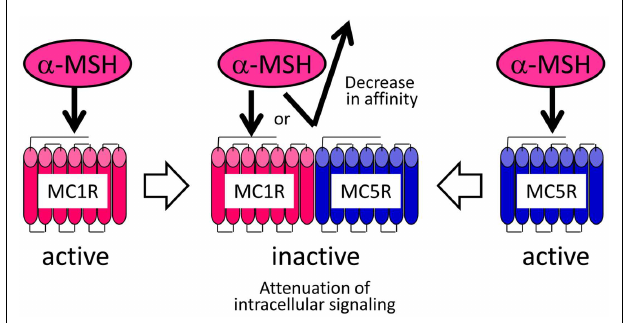
FIGURE 5 | Heteromer hypothesis explaining the negligible activities of α -MSH in flounder melanophores .